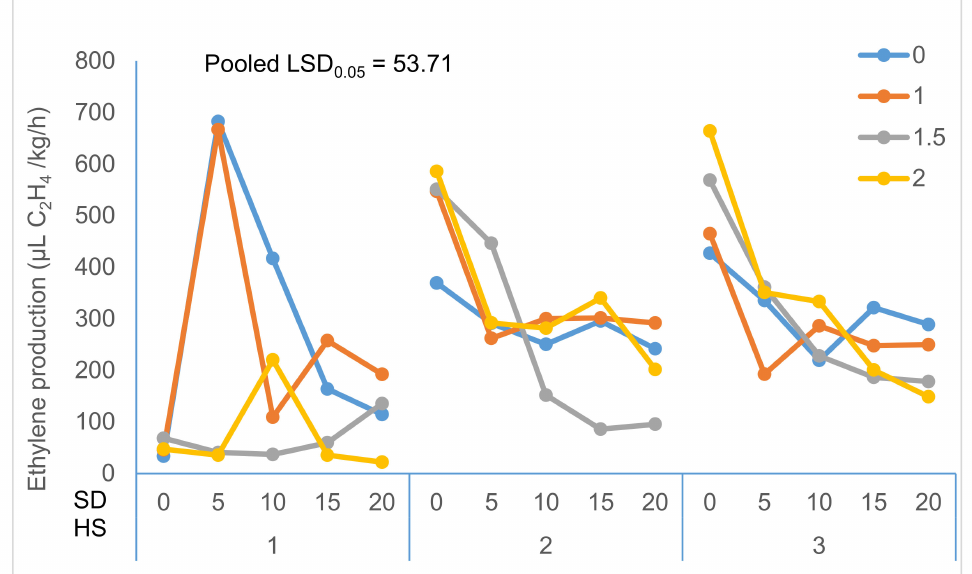
Figure 1. The interaction effects of CaCl 2 (0, 1%, 1.5%, and 2%, w / v ), harvesting stages (HS: 1 = green mature, 2 = breaker and 3 = half ripe) and storage durations (SD: 0, 5, 10, 15 and 20 days) on the ethylene production of tomato fruit stored at ambient temperature (28 ± 2 ◦ C and 75 ± 5% RH). Pooled LSD 0.05 = 53.71.